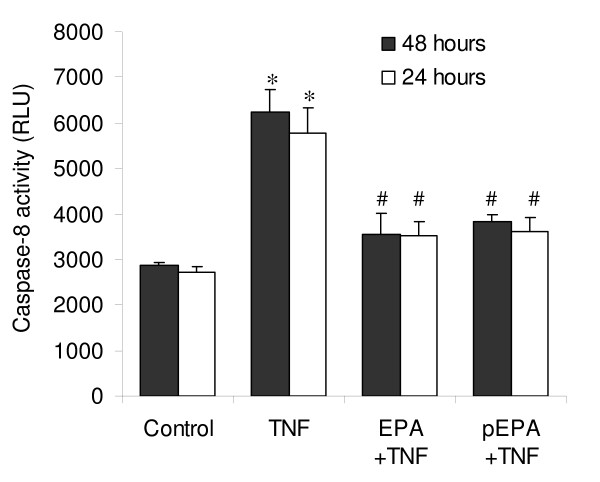
EPA inhibits the TNF-α-induced caspase-8 activity associated with apoptosis. The nature of the pro-apoptotic effect of TNF-α on C2C12 myotube formation and its prevention by EPA were examined after 24 or 48 hours in DM by evaluating caspase-8 activation (measured in relative light units, RLU) using the Caspase Glo-8 commercial assay. EPA was added together with TNF-α as a co-treatment (EPA+TNF) or, alternatively EPA was administered alone for a 2 hour pre-treatment after which it was withdrawn and replaced by TNF-α alone in DM (pEPA+TNF). Data are expressed as means ± standard error of mean (SEM) from 3 independent experiments. (*p < 0.05 v. respective control; #NS v. respective control).